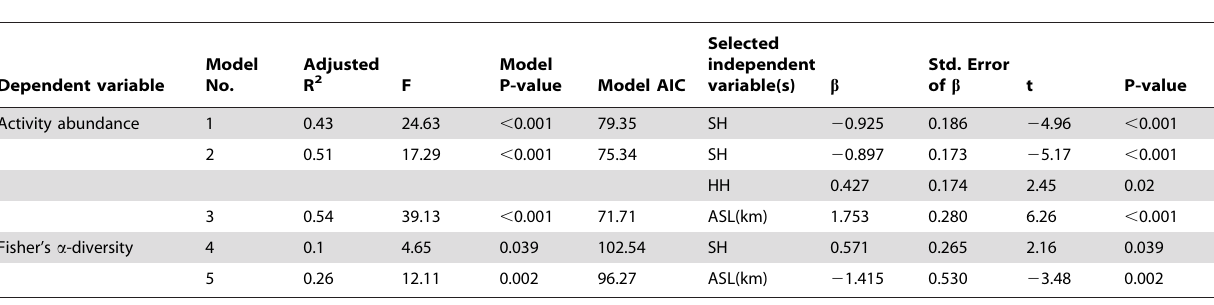
Table 1. Stepwise linear regression models using activity abundance and Fisher’s a -diversity of carabids as dependent variables, respectively, only using vegetation parameters as independent variables (Model 1, 2 and 4) and including elevation as additional independent variable (Model 3 and 5).